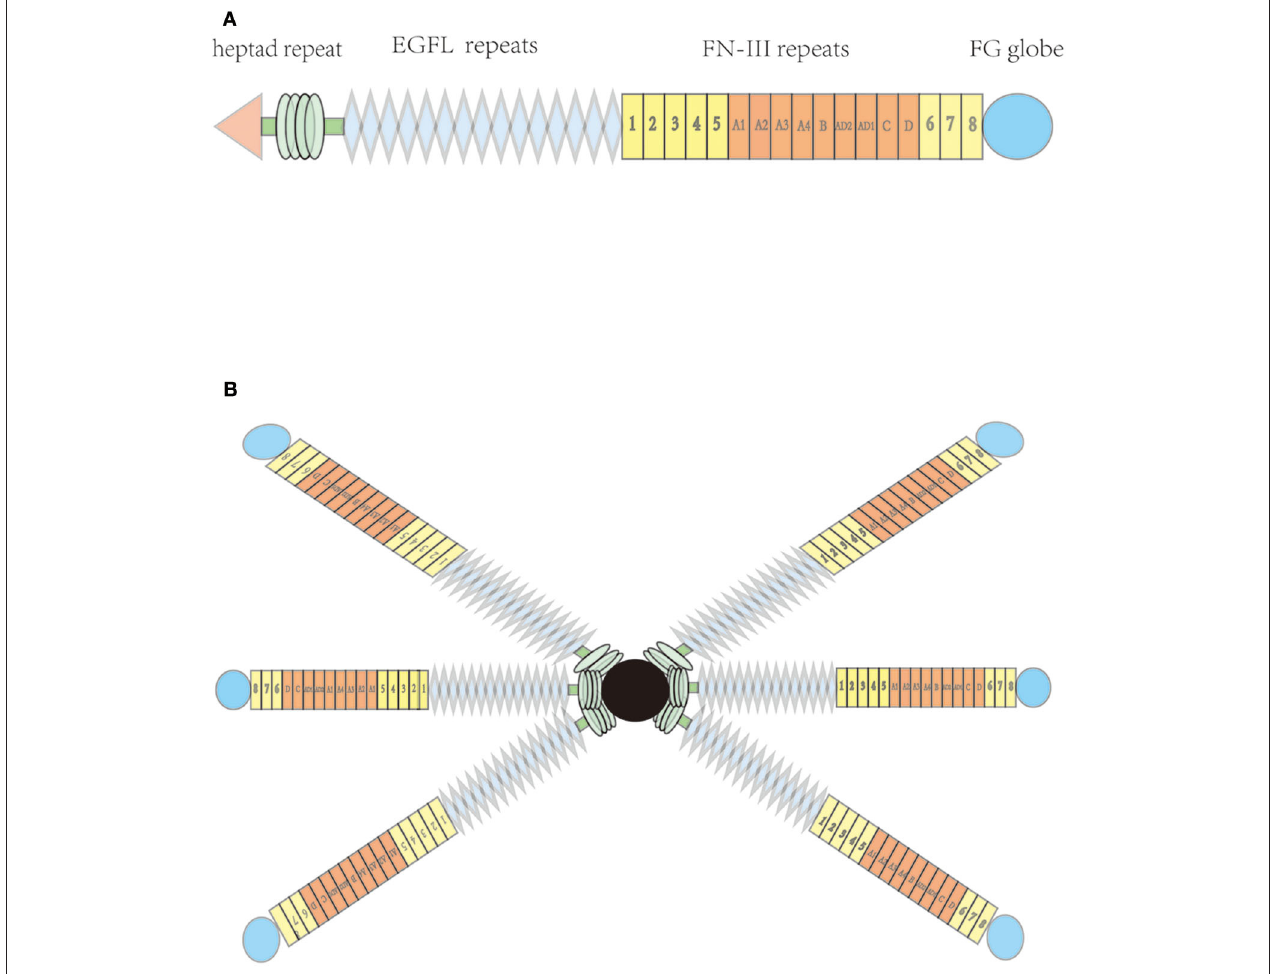
FIGURE 1 | Molecular structure of tenascin-C; (A) Each subunit, including heptad repeat, epidermal growth factor-like (EGFL) repeats, fibronectin type III (FNIII) domains, and a C-terminal globular fibrinogen-homology domain (B) hexabrachion of the tenascin